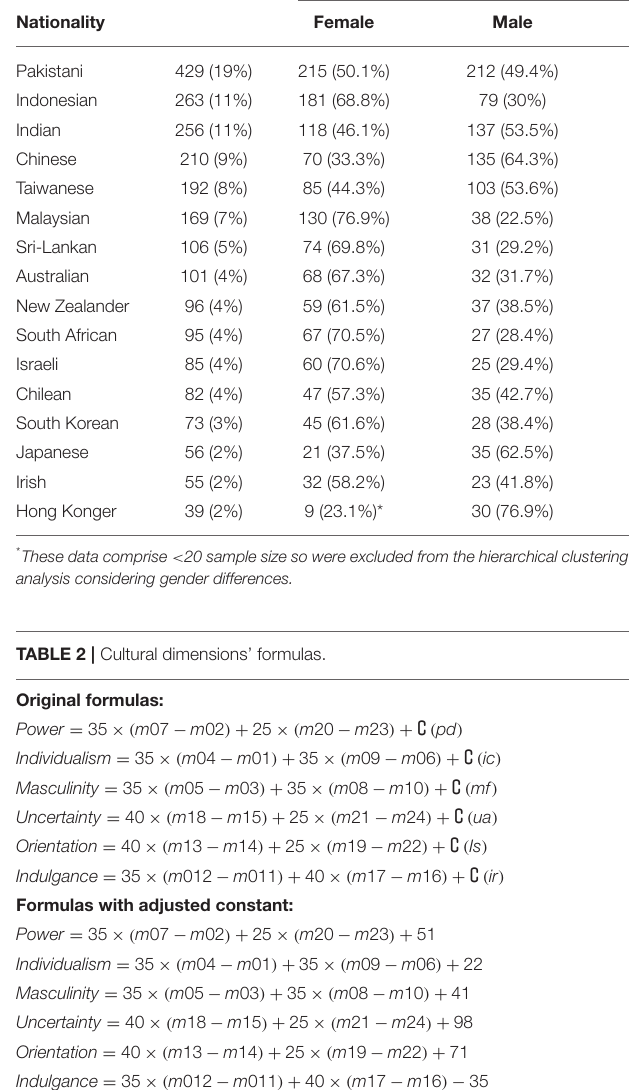
( INDULGENCE = − 2: Figure 1 ). P OWER had the smallest mean difference range ( Range = 45; SD = 12), with UNCERTAINTY having the greatest distribution ( Range = 113; SD =